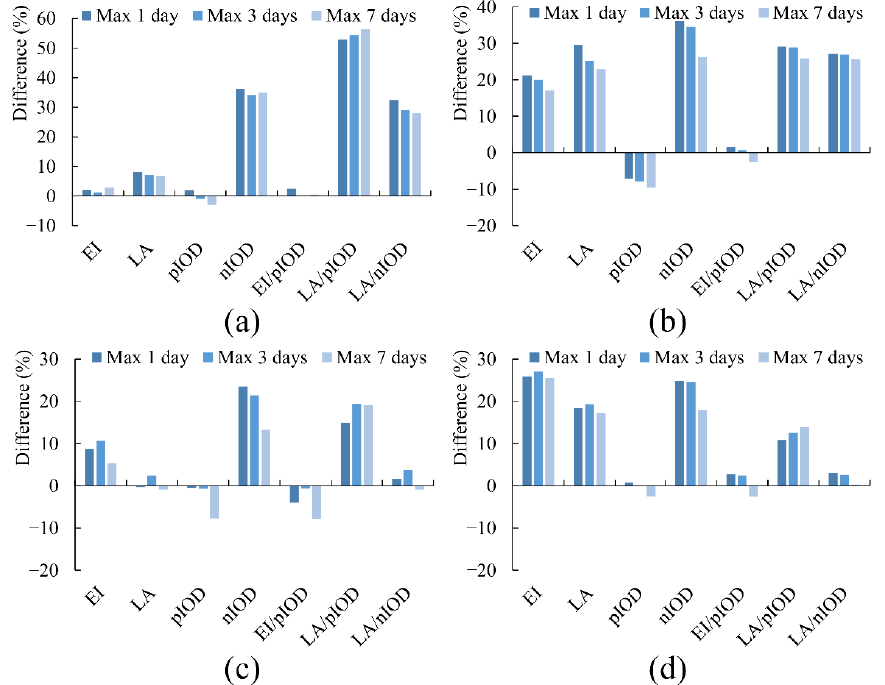
Figure 9. The difference in 1-day/3-day/7-day maxima streamflow relative to neutral years in decaying years at ( a ) Zhimenda, ( b ) Shigu, ( c ) Tongzilin, and ( d ) Xiangjiaba.